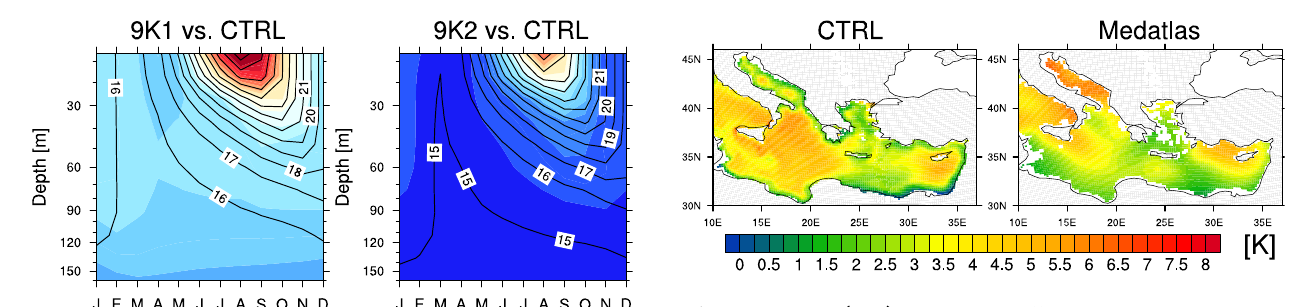
Fig. 12. Summer (JAS) temperature difference between 6 and 27m of depth, for CTRL and MEDATLAS